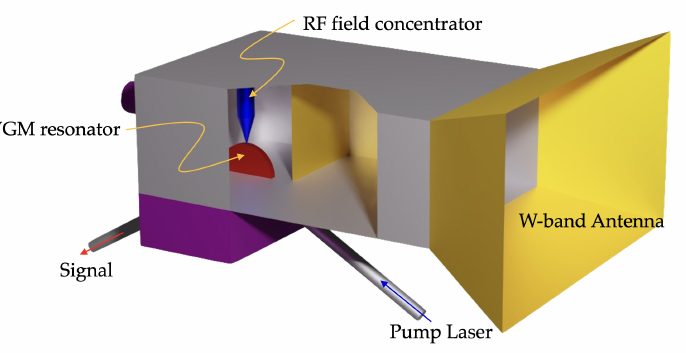
Figure 1. Conceptual design of the W-band microwave photonic receiver. A WGM resonator is interrogated by coherent light. A signal of interest enters the horn antenna and propagates to the WGM resonator, reaching high intensity in the vicinity of the resonator surface due to a special configuration of RF field concentrator electrodes. Due to the electro-optical effect, the signal is upconverted to the optical frequency domain and leaves the resonator through the optical port. The signal is subsequently optically processed and downconverted to the IF domain (not shown in the